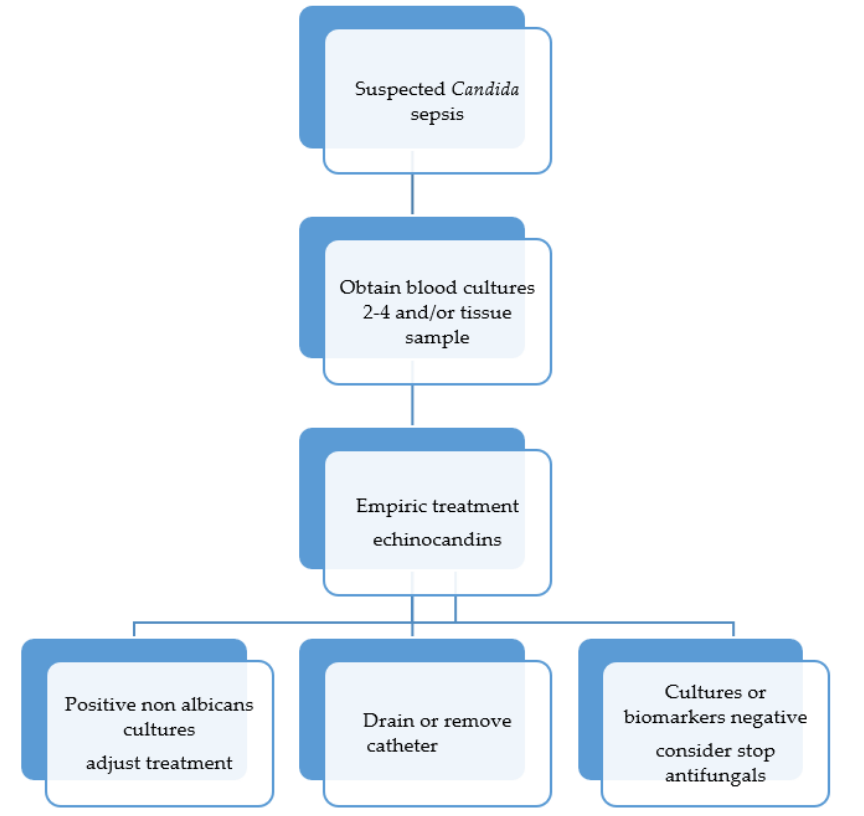
Figure 4. Algorithm for management of Candida sepsis adapted from Keighley et al. and Thompson et al. [94,95].